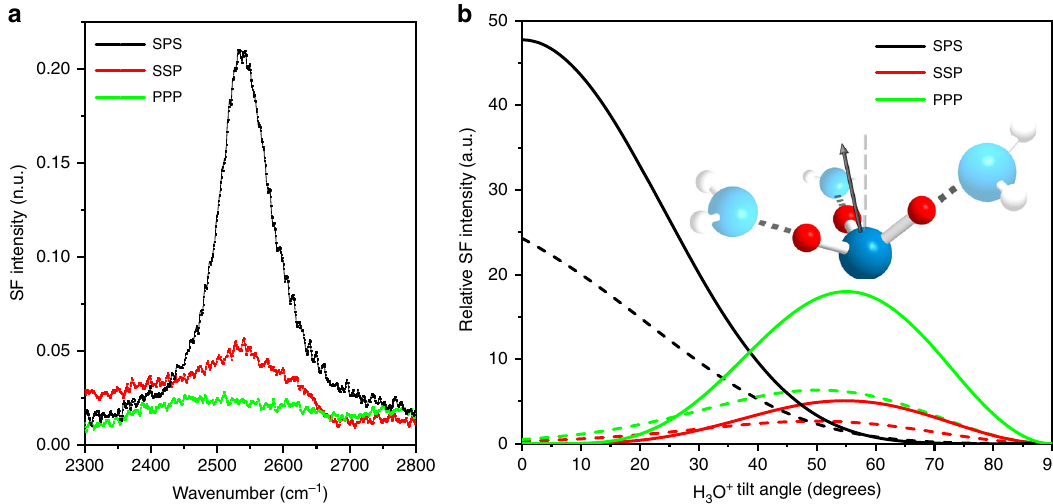
Fig. 3 Polarization dependence and orientational analysis of the hydrated Eigen proton. a VSF spectra collected in the polarization combinations SPS, SSP, and PPP of a dAA monolayer on a 1 μ M NaCl solution in H 2 O (surface pressure 20 mN m − 1 ). b Theoretical curves showing the expected variations of the SF intensity of the antisymmetric stretch of H 3 O + (C 3v symmetry) as a function of tilt angle of the C 3 axis from the surface normal for the three polarization combinations, assuming a delta distribution (solid lines), and Gaussian distribution with standard deviation of 15° (dashed lines). See Supplementary Note 2 for details of the model. The sketch depicts the orientation of the hydronium core with the arrow along the C 3 axis. Experimental observations are consistent with the C 3 axis aligned closed to the surface normal. In the sketch, the oxygen and hydrogen atoms of the core Eigen proton are depicted as blue and red spheres, respectively. In the fl anking water molecules, oxygen atoms are in light blue, while hydrogens are illustrated as white spheres.